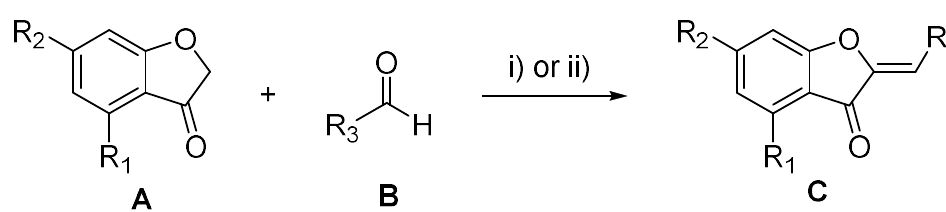
Scheme 1. Preparation of aurone derivatives. Reagents and conditions: (i) benzofuranone (1 equiv.), aldehyde (1.2 equiv.), aq. 4N KOH (20 equiv.) MeOH (0.1 M), reflux, for 30 min and (ii) benzofuranone (1.0 equiv.), aldehyde (1.0 equiv.), 12N HCl (0.1 equiv.). EtOH (0.25 M), reflux, for 3 h. Table 2 lists the structures and IC 50 values of various 2-methylenebenzofuran-3(2 H )- one derivatives that were selected for chemical synthesis among the virtual hits of de novo design. The substitution points included C4 (R1) and C6 (R2) positions of the benzofuran- 3(2 H )-one ring as well as the β carbon (R3) with respect to the carbonyl group. It is interesting to note that three derivatives ( 5–7 ) were previously reported as the inducers of NAD(P)H:quinone oxidoreductase 1 (NQO1) [47]. Overall, eight of the twelve synthesized derivatives exhibit high biochemical potency at the sub-micromolar level against PIM1. This result exemplifies the accuracy of the modified binding free energy function with which the new PIM1 inhibitors were designed so as to maximize the binding affinity and simultaneously to minimize the dehydration cost for binding in the ATP-binding site. Table 2. Structures and biochemical potencies of the derivatives of 2 with respect to PIM1 kinase. a